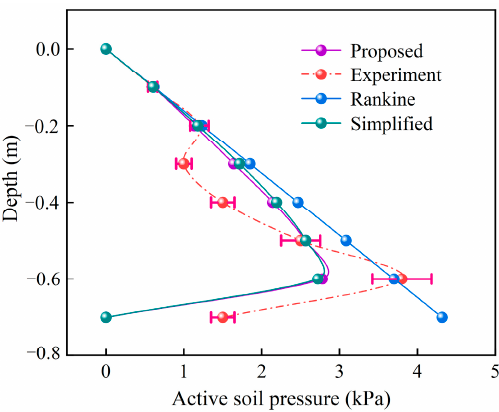
Figure 15. Distribution of finite soil pressure compared with experiment.